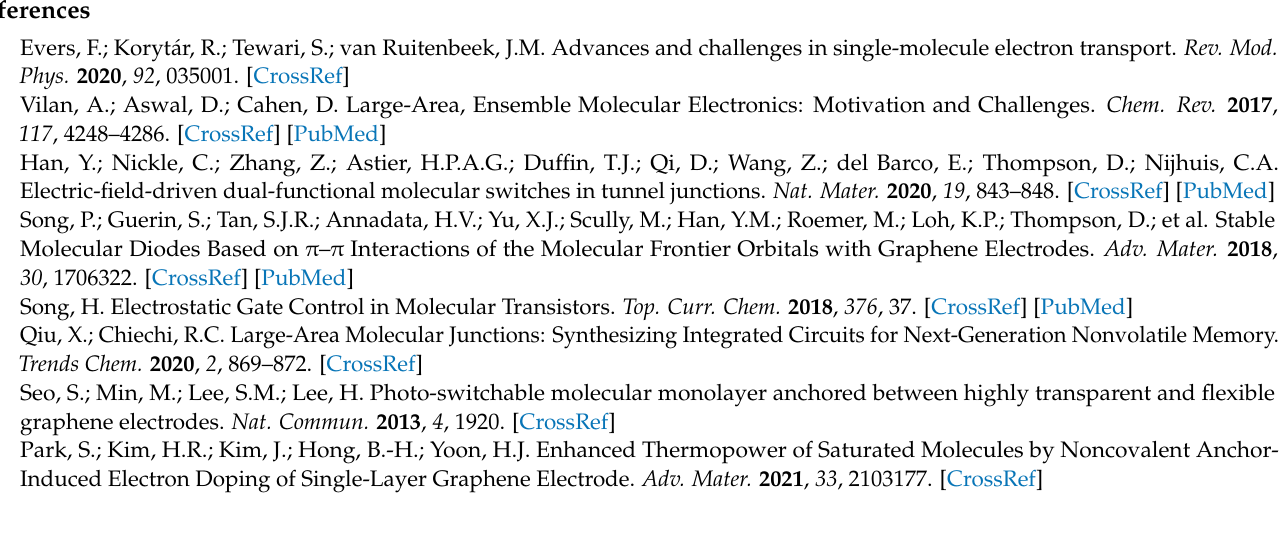
line profile analyses; Figure S2: Intensity ratio and shift of Raman peak; Figure S3: Surface roughness; Figure S4: Representative J − V curves of C10 and C12